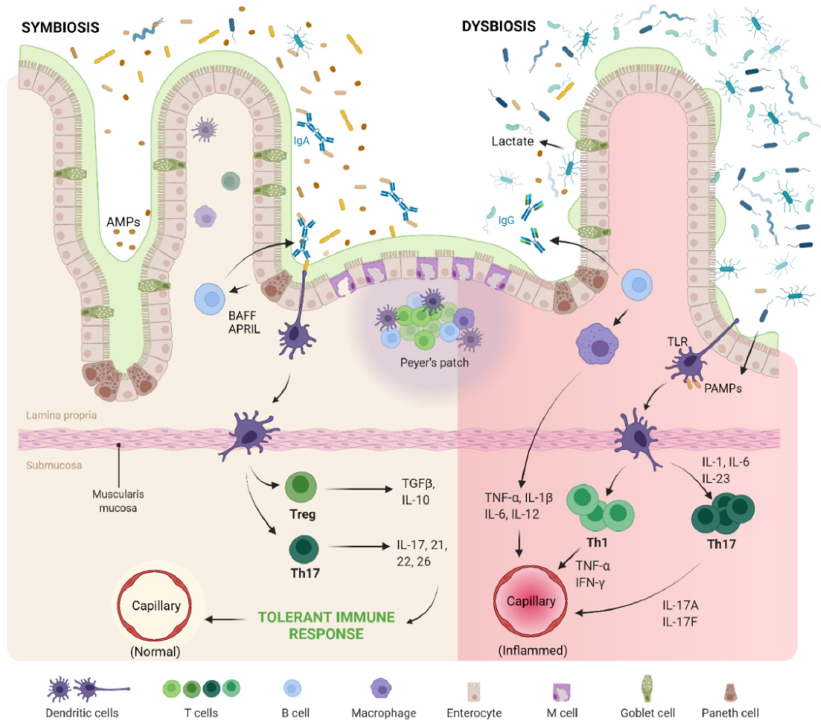
Figure 1. Mechanism of regulation of immune response by gut microbiome. The native immune system is tolerant to the resident gut microbiome under the tight control of intestinal epithelial cells using mucosal barrier, secretory IgA and antimicrobial peptides (AMP). The native gut microbiome stimulates the intestinal epithelial cells, dendritic cells and macrophages to activate the T regulatory (T reg) cells and T helper 17 (Th17) cells. Upon activation of the intestinal epithelial cells with toll-like receptors (TLRs), B-cell activating factor (BAFF) and a proliferation inducing ligand (APRIL) are secreted which promotes the differentiation of IgA producing plasma cells, whereas in dysbiotic status of gut microbiome with the loss of barrier integrity and breach in the intestinal epithelial cell barrier, translocation of bacterial components, pathogen-associated molecular patterns (PAMPs), intestinal immune system is triggered through TLR activation. This results in an inflammatory cascade through hyperactivation of T helper 1 (Th1) and Th17 cells resulting in section of inflammatory